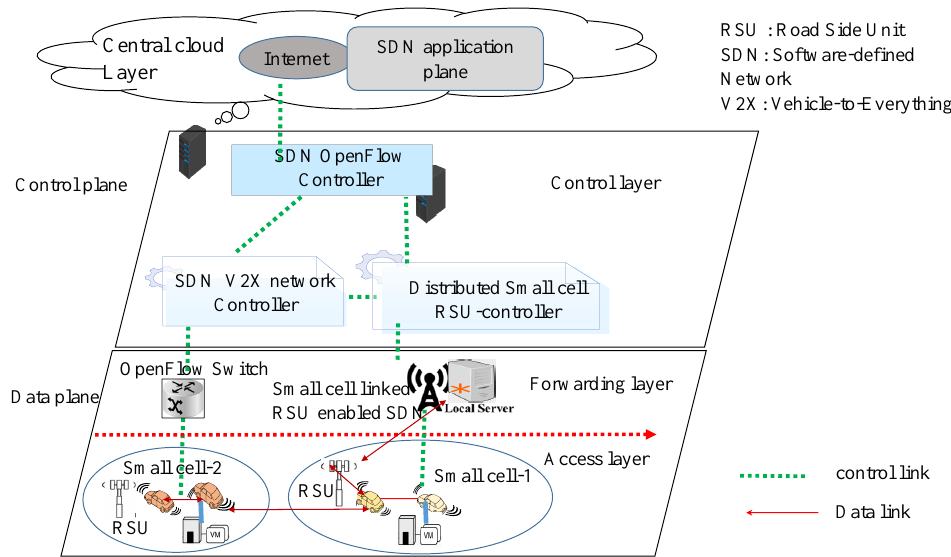
Figure 2. The diSRsVN architecture with small cells linked to RSU. Table 1. Definition of functional components of the